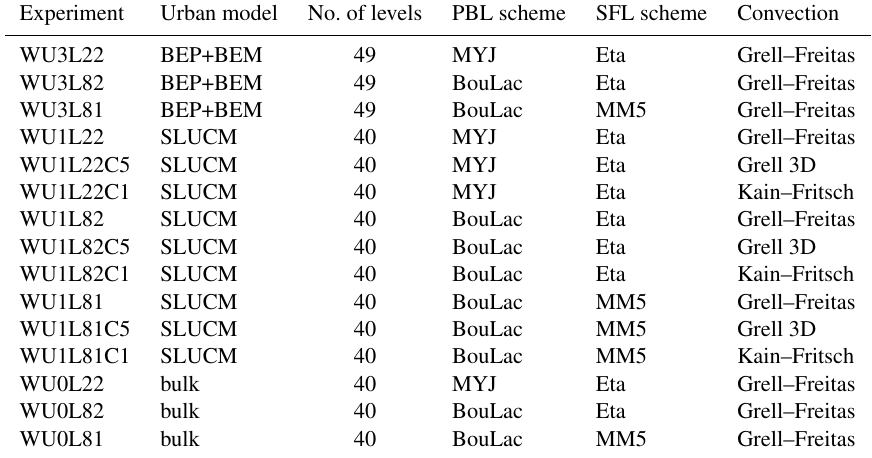
Table 1. WRF model setups.